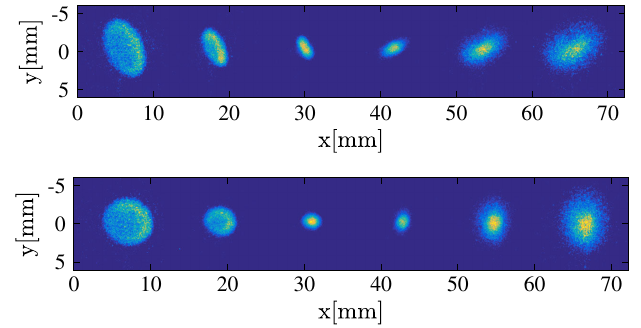
FIG. 4. Transverse beam profile captured on the YAG screen during the measurement with the solenoid strength increasing from left to right (underfocus to overfocus). The rms laser spot size is 2.7 mm. Top: Without the quadrupole corrector. The measured emittance is 1 . 42 mm mrad = mm. Bottom: With the quadrupole corrector. The strength is 72 G = m, the rotation angle is 70°, and the measured emittance is 1 . 14 mm mrad =